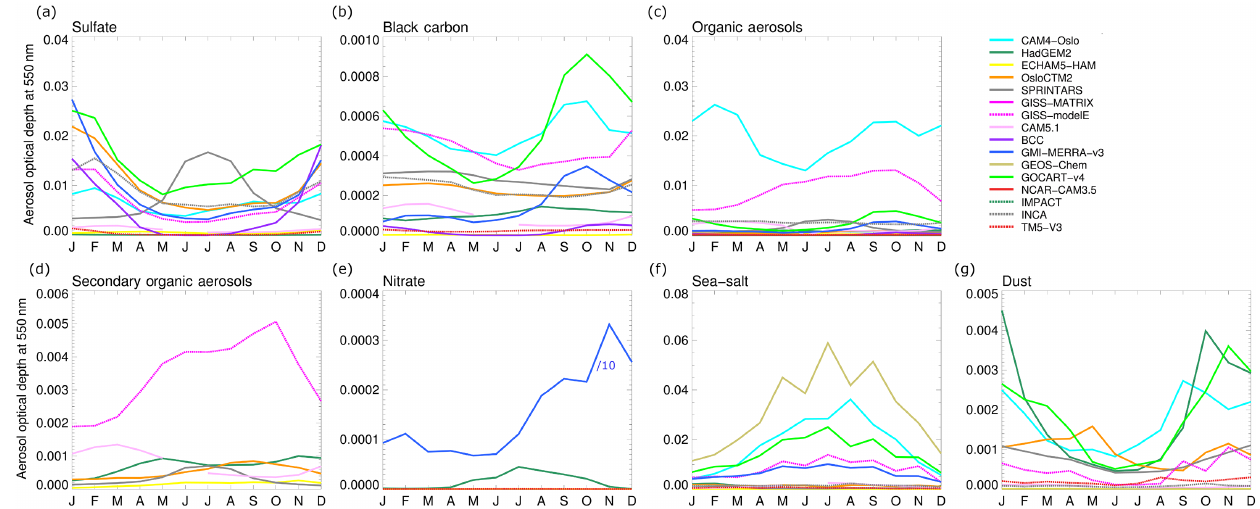
Figure 11. Multi-model seasonal cycle Antarctic mean (70–90 ◦ S) AOD for the individual components (a) sulfate, (b) BC (from all sources),